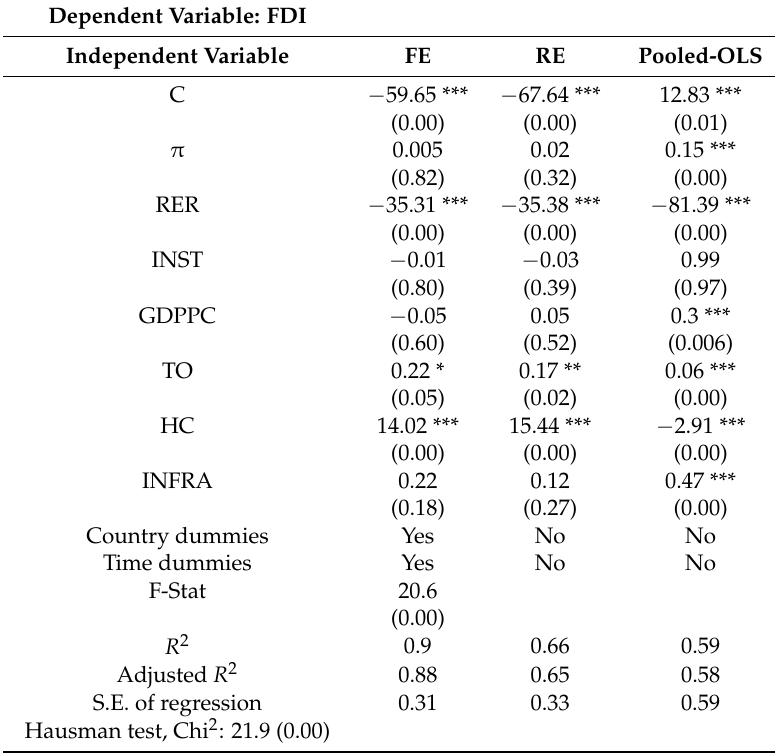
Table 4. Estimation